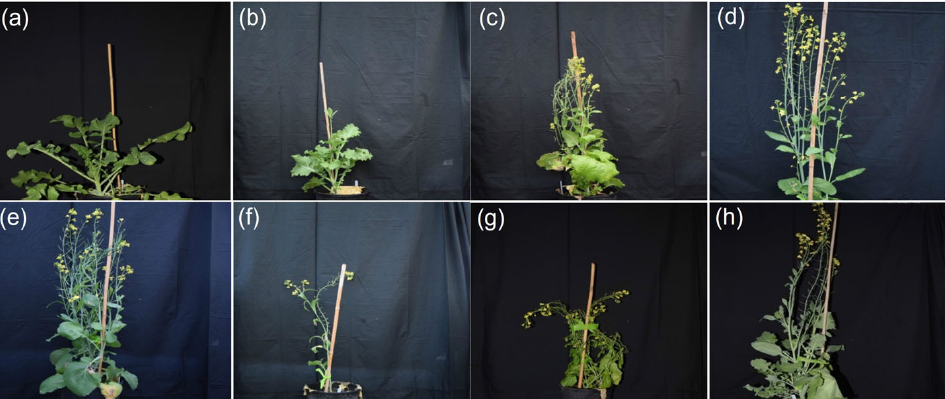
Figure 1. Phenotypic variation in S 2 generation derived from a hexaploid Brassica hybrid H16 ‐ 1. ( a ) Good vegetative growth with delayed bolting. ( b ) Weak growth with late bolting. ( c ) Weak growth but bolted. ( d ) Blossomed with low fertility (empty pods). ( e ) Blossomed with high fertility (pods with many seeds inside). ( f ) Few branches. ( g ) Many branches. ( h ) Tall plant.